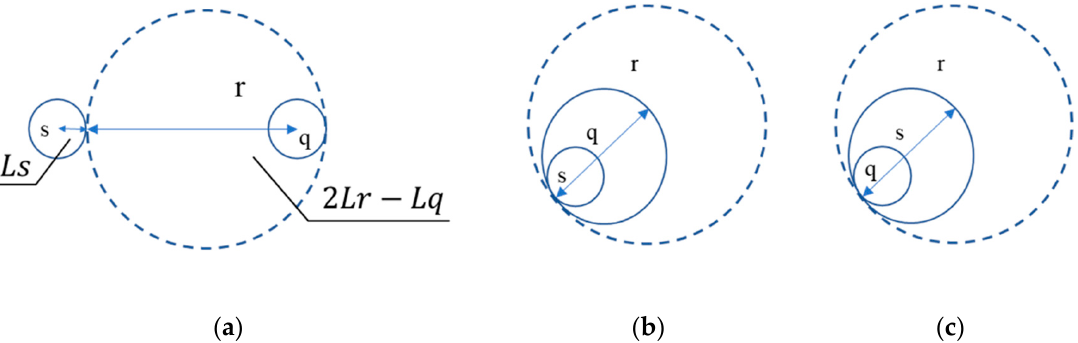
Figure 4. Nested relation inference for virtual node. ( a ) Virtual node level constraint; ( b ) Virtual node same-tree constraint with s on a higher level than q ; ( c ) Virtual node same-tree constraint with s on a lower level than q . r is a virtual node, q is a real child of r , s is a real node, Lr is the latency guarantee of r , Lq is the latency guarantee of q